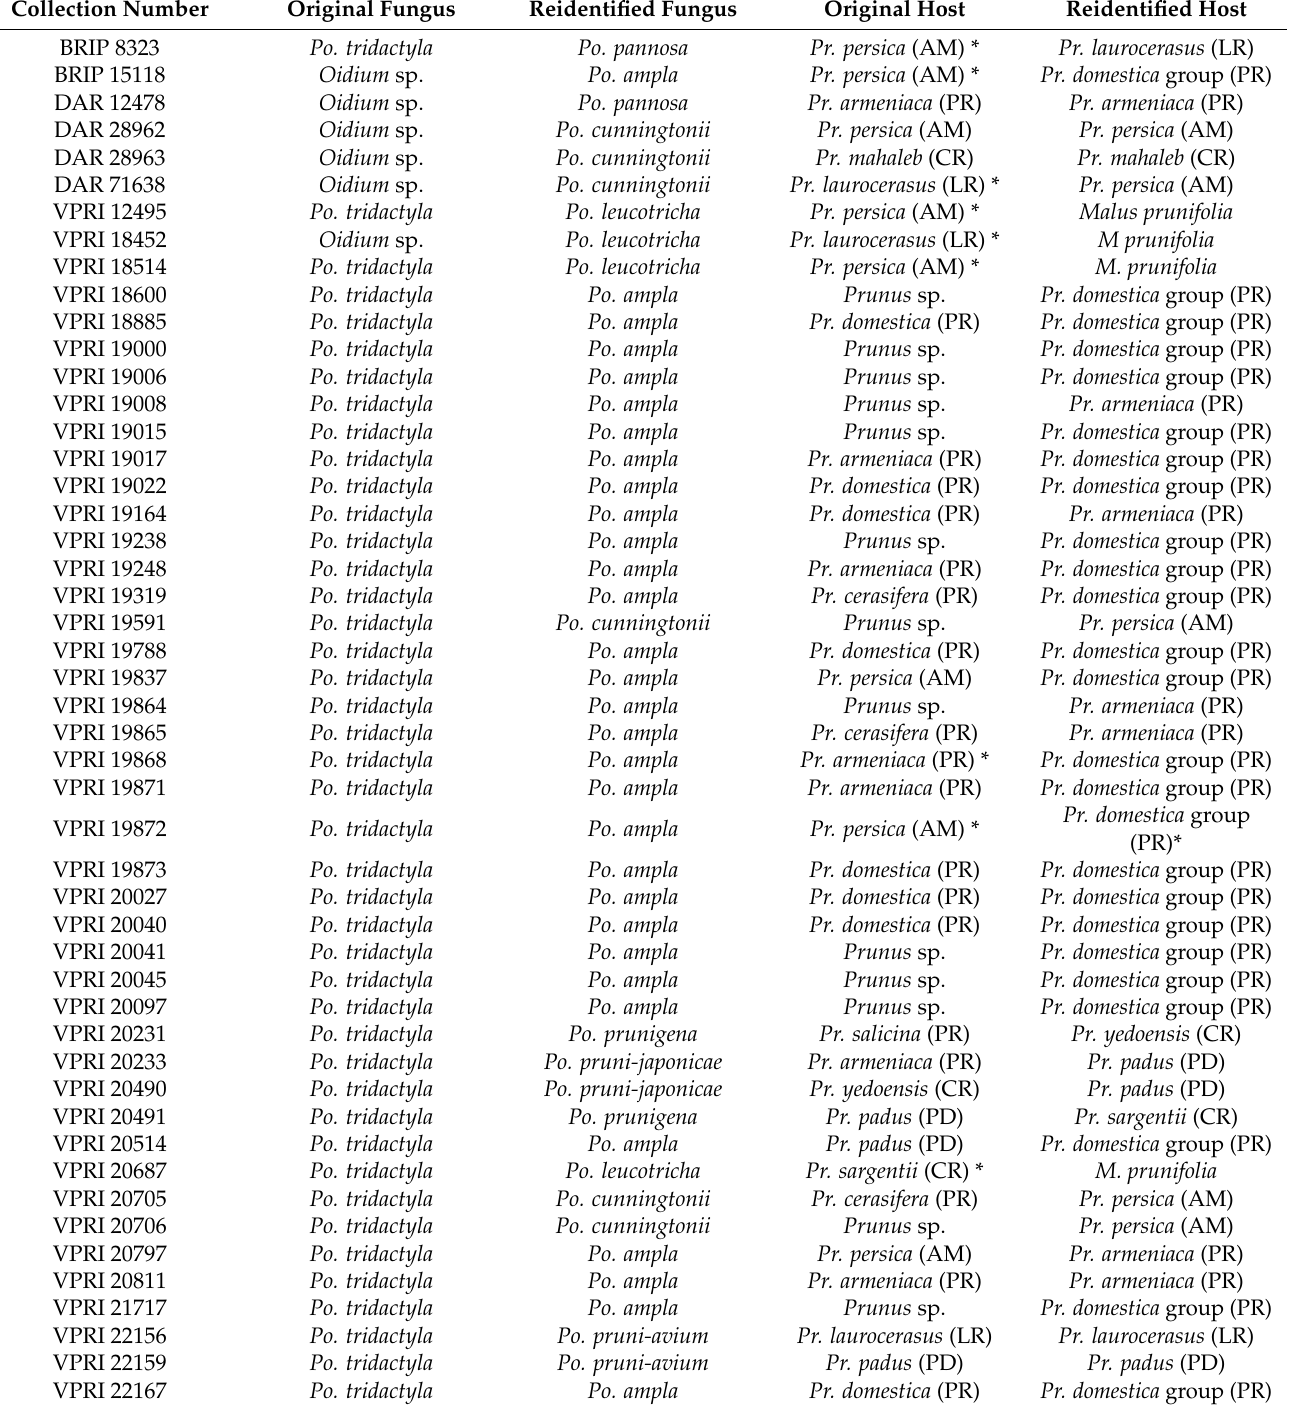
Table 2. Powdery mildew fungal specimens with updated fungus and host species names. These revised identifications are based on ITS+28S and chloroplast gene matK phylogenies, respectively. For hosts, abbreviations in brackets refer to divisions within Prunus : AM: subgenus Prunus section Amygdalus , CR: subgenus Cerasus , LR: subgenus Padus section Laurocerasus , PD: subgenus Padus section Padus and PR: subgenus Prunus section Prunus . The Prunus domestica group includes Pr. domestica , Pr. cerasifera and Pr. salicina , which are not readily distinguishable in the host matK phylogeny. * Indicates a host that was originally misidentified. Po . = Podosphaera , Pr . = Prunus